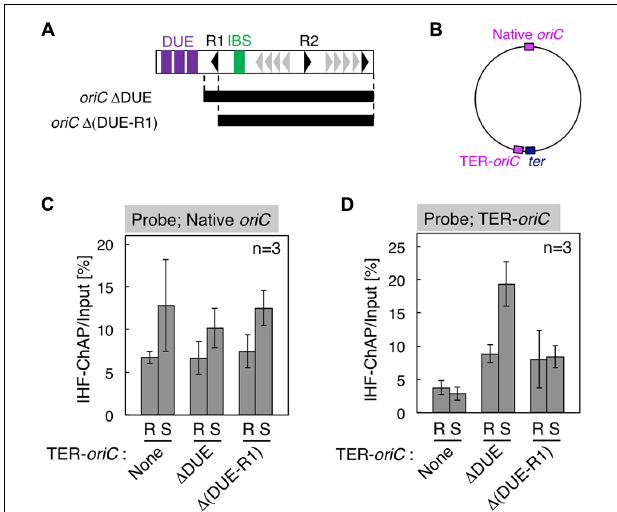
FIGURE 5 | Requirement for DnaA box R1 for oriC –IHF binding at the replication initiation period. (A) Deletion derivatives of oriC . Bars indicate the regions of oriC (cid:49) DUE and oriC (cid:49) (DUE-R1), which were inserted at the position indicated as TER- oriC in the terC locus [shown in panel (B) ] of SH022 ( dnaC2 ) strain, resulting in strains KX237 and KX238. Symbols used for the oriC structure are shown as in Figure 1B . (C,D) IHF-ChAP-qPCR with TER- oriC -inserted cells. SH022 ( dnaC2 ), KX237 ( dnaC2 TER- oriC (cid:49) DUE), and KX238 [ dnaC2 TER- oriC (cid:49) (DUE-R1)] cells grown at 30 ◦ C (R; Random) were transferred to 38 ◦ C and incubated for 90 min (S; Synchronized). The relative levels of native oriC (C) and TER- oriC (D) before and after Ni-affinity purification were determined using real-time qPCR, and yield was calculated (expressed as %). Error bars represent standard deviation from three independent